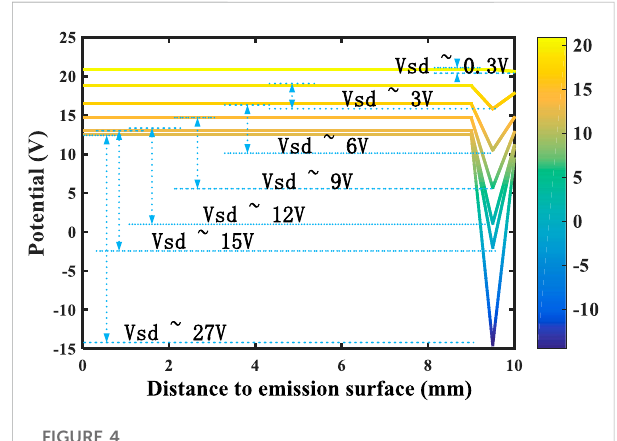
FIGURE 4 The potential distribution from the emission surface (Distance to emission surface = 0 mm) to the PG (Distance to emission surface = 10 mm).